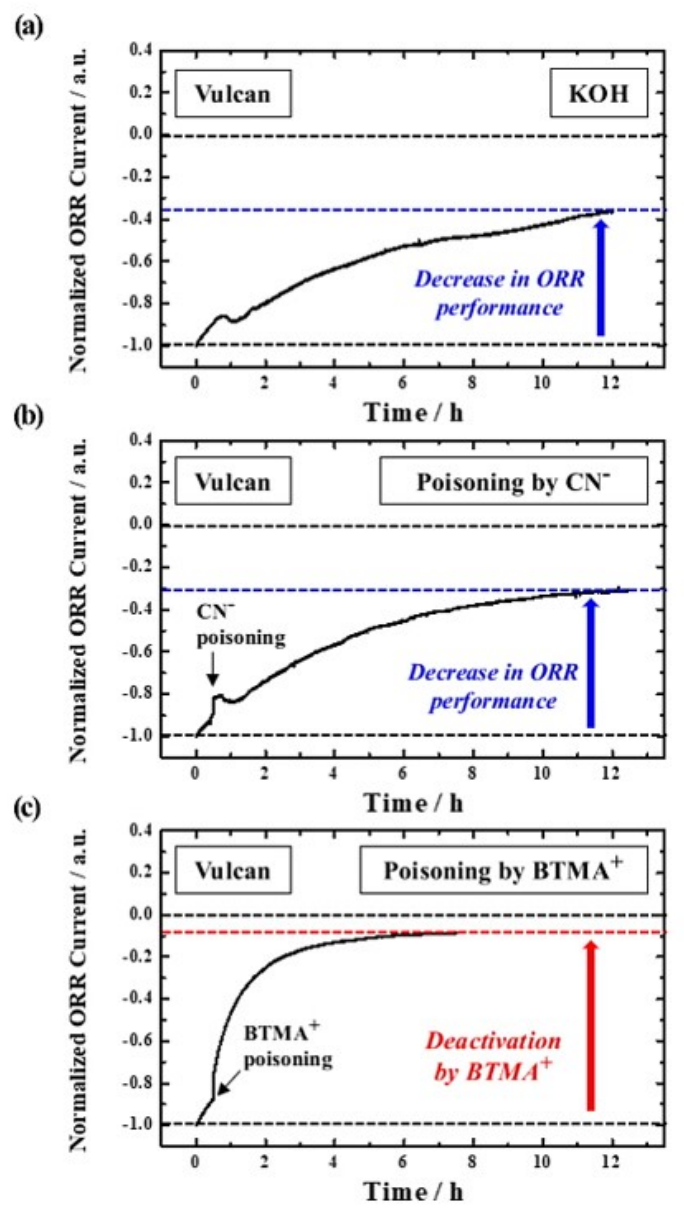
Figure 3. Chronoamperograms of Vulcan XC − 72 at 0.7 V in O 2 − saturated ( a ) 0.1 M KOH, ( b ) 0.01 M KCN − mixed 0.1 M KOH, and ( c ) 0.1 M BTMAOH.